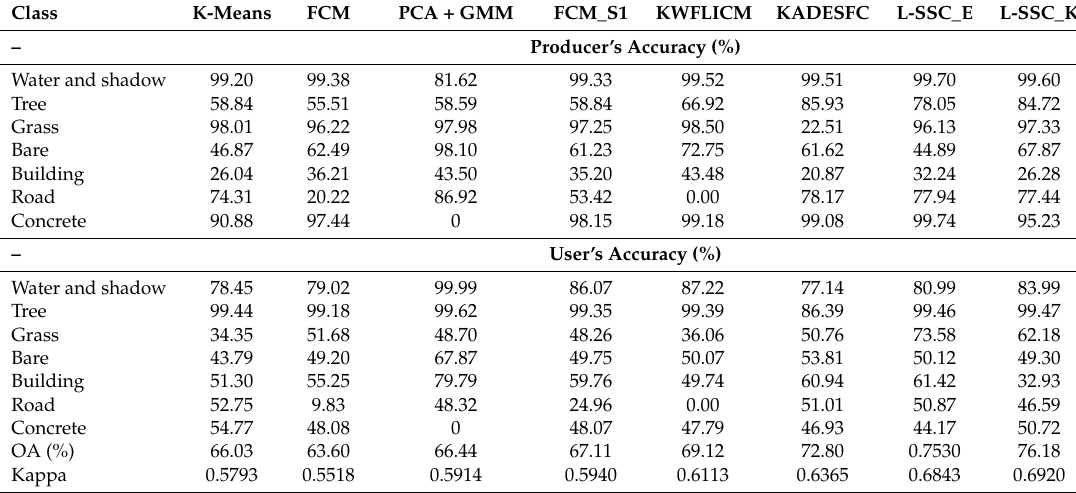
Table 4. Comparison of clustering accuracy for the Fancun